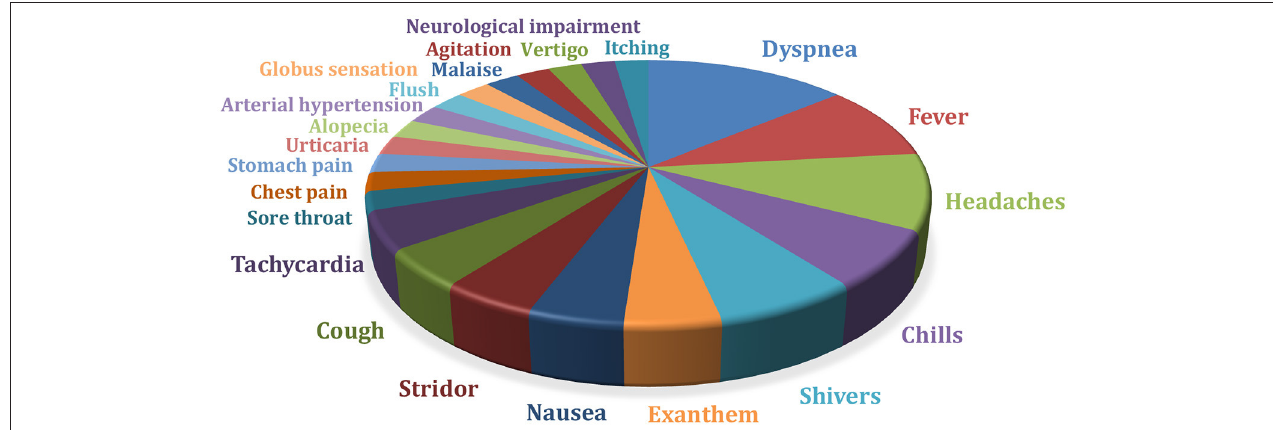
FIGURE 4 | TRR, treatment-related reactions in a total of 259 infusions administered in n = 76 patients (in some cases several TRR occurred per infusion) ( n = 76); neurological impairment = aphasia, hypersalivation, tingling